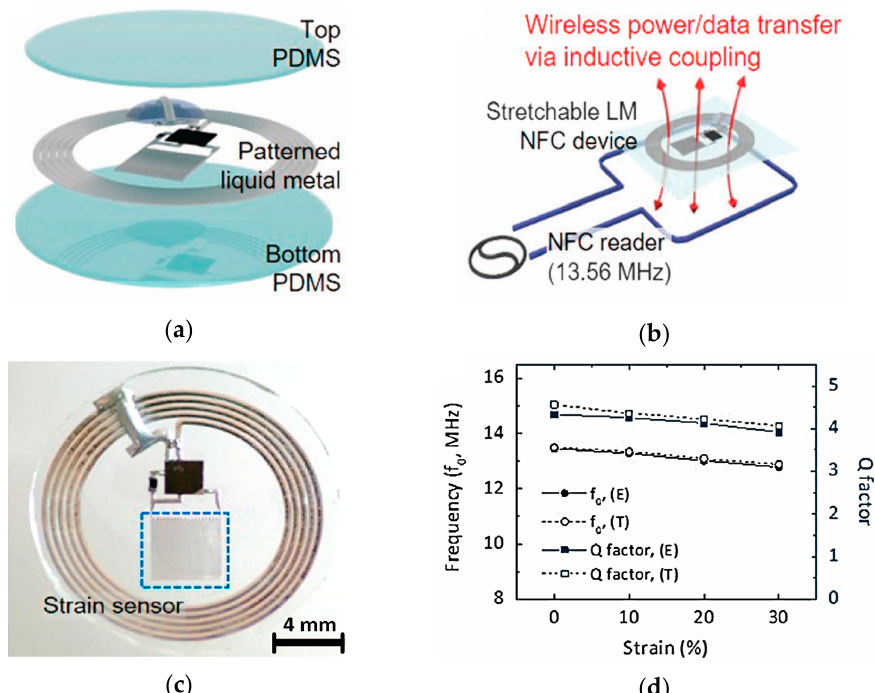
Figure 12. ( a ) Exploded view of the wearable coil antenna with Galinstan LM patterning encapsulated in PDMS encapsulation; ( b ) antenna operation; ( c ) fabricated coil antenna; and ( d ) comparison of experimental and theoretical performance of antenna as a function of strain [43].